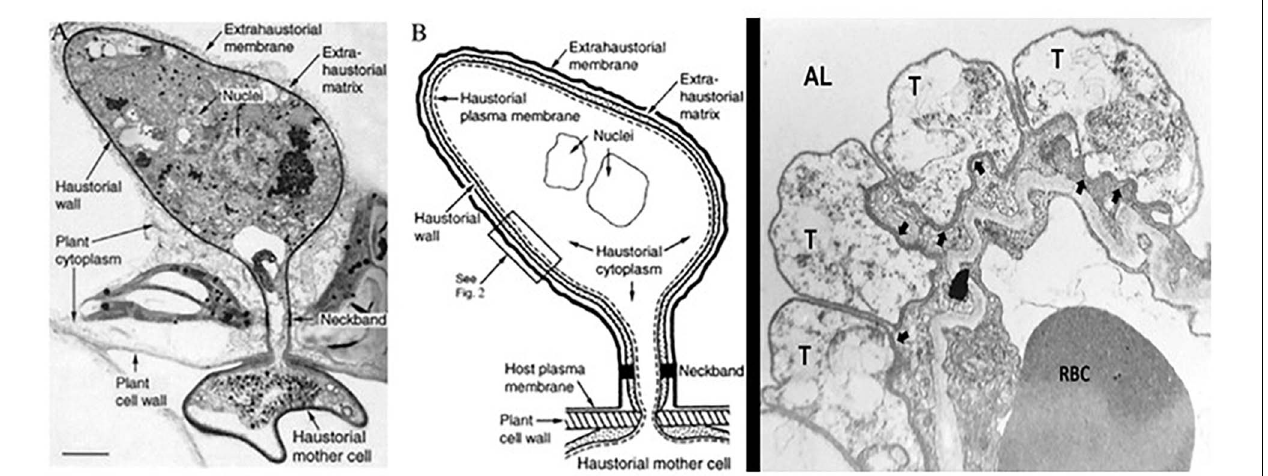
FIGURE 3 | Haustorial complex, a specialized feeding organ of biotrophic fungal parasites of plants. To move from host cell to fungus, nutrients must traverse the extrahaustorial membrane, the extrahaustorial matrix, the haustorial wall, and the haustorial plasma membrane. A neckband seals the extrahaustorial matrix from the plant cell wall region so that the matrix becomes a unique, isolated, apoplast-like compartment. The haustorium connects to intercellular fungal hyphae by way of a haustorial mother cell. A proton symport system in the haustorial plasma membrane drives sugar transport from plant to parasite. (A) Transmission electron micrograph of a flax rust haustorium [Reproduced with permission from ref. 2 (Copyright 1972, NRC Research Press)] (Bar, 1 µ m). (B) Drawing showing key features of the fungal haustorium. (C) Electron micrograph of Pneumocystis trophic forms in tight apposition with the AEC1 in the lung alveoli. Trophic forms (T); Alveolar Lumen (AL); Red Blood Cell (RBC); arrows indicate the tight apposition of the trophic form double membrane with the AEC1 membranes. From the collection of